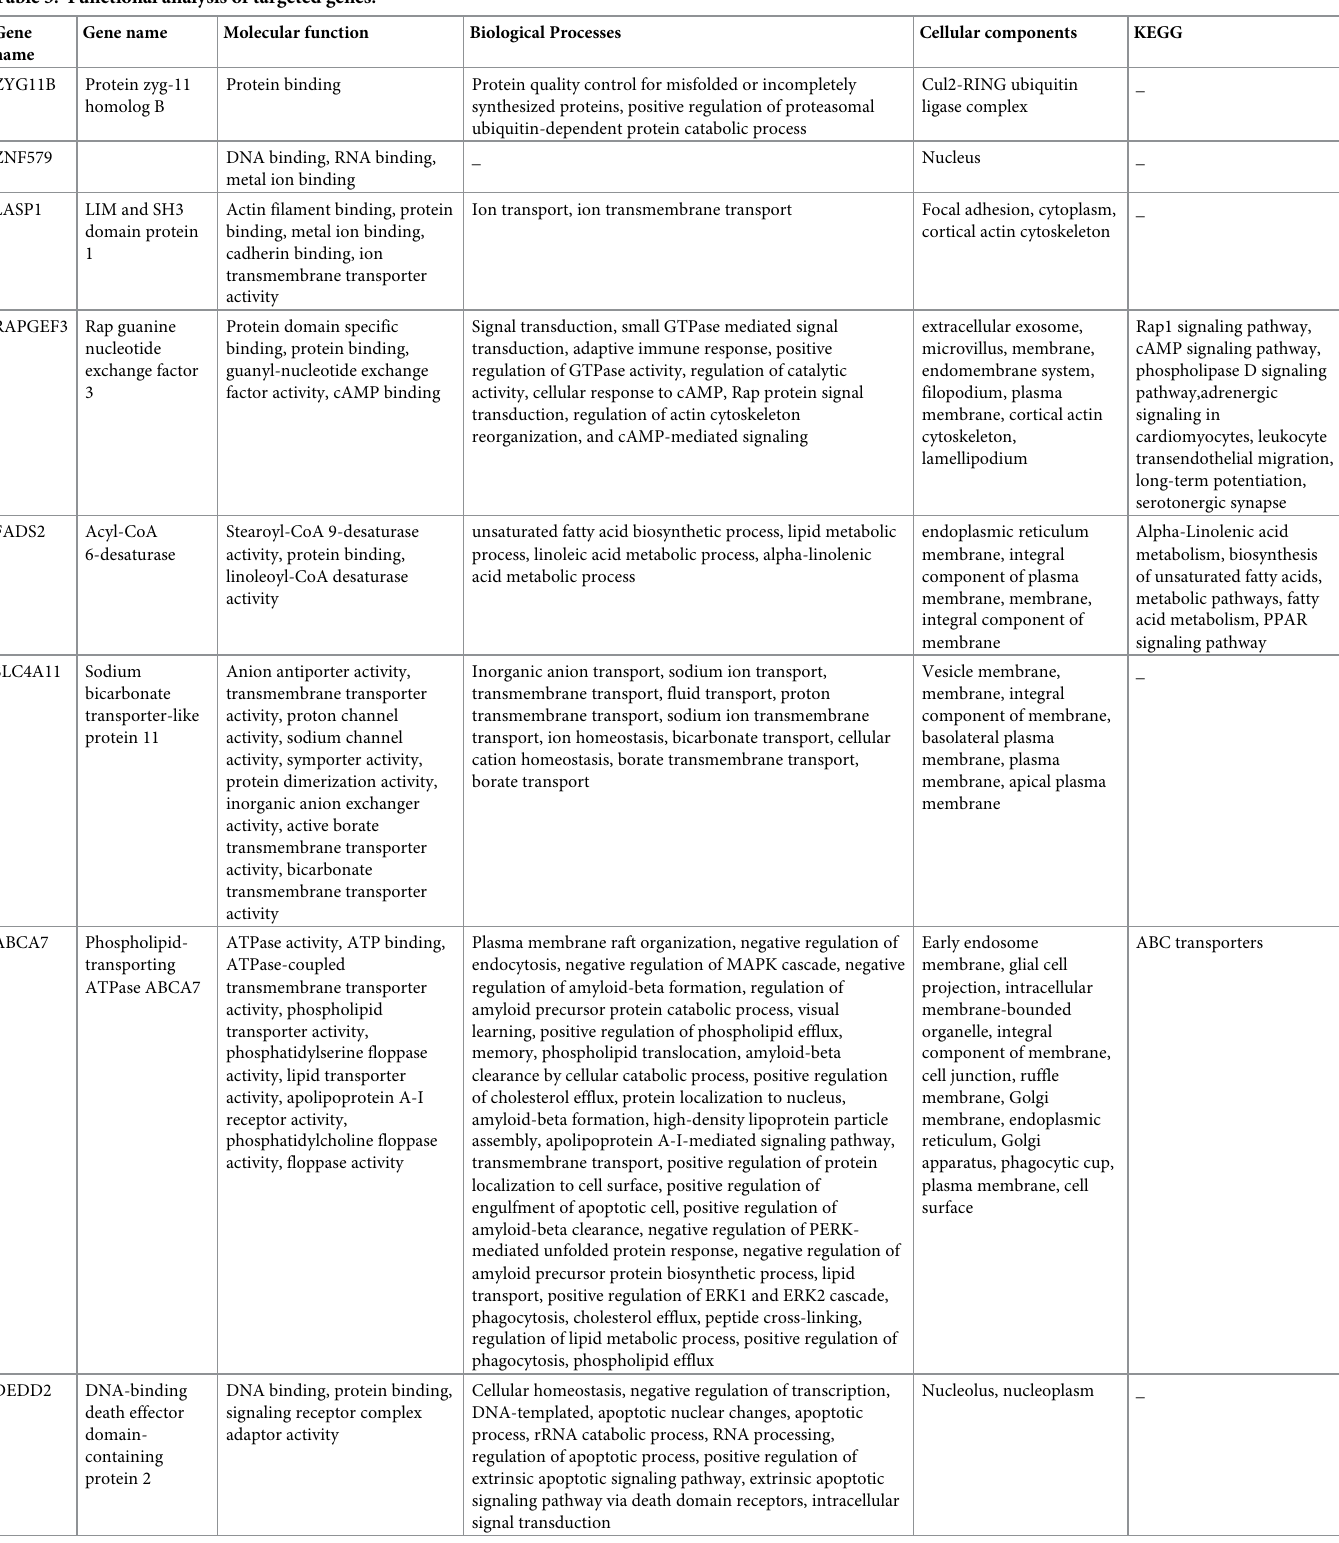
Table 3. Functional analysis of targeted